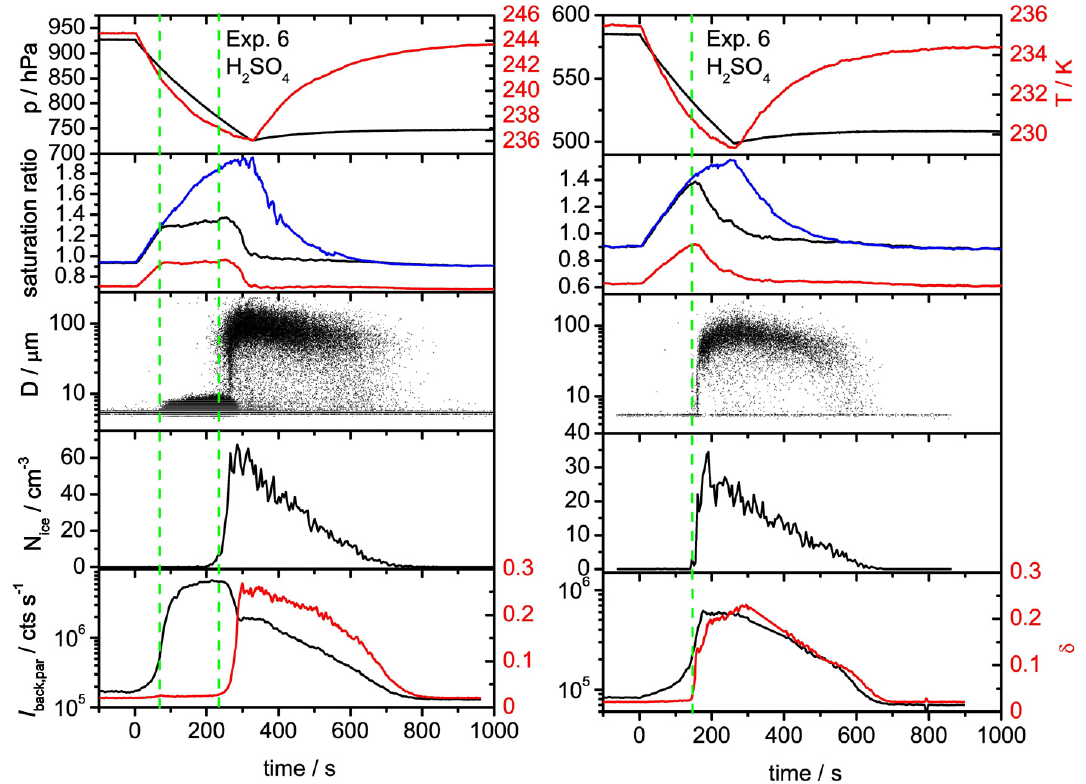
Fig. 13. Time series of various AIDA records during two expansion cooling cycles from Exp. 6 that were started at 244 and 235K. The individual panels show the same measurements as in Fig. 5, except from panel 4 where the ice particle number concentration N ice instead of the ice-active fraction f ice is